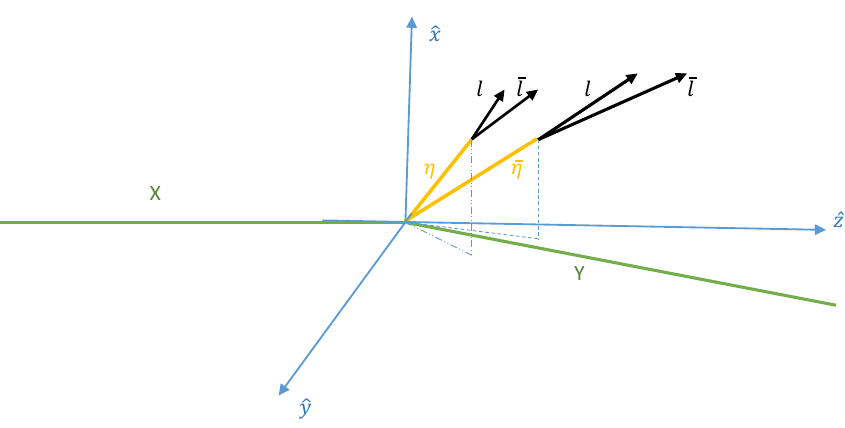
Figure 3 . Schematic demonstration of the X decay into Y , (cid:17) and (cid:22) (cid:17) and the subsequent production of charged lepton pairs from the (cid:17) and (cid:22) (cid:17) decays. ^ z is along the beam direction (i.e. along the line connecting FASER (cid:23) to the